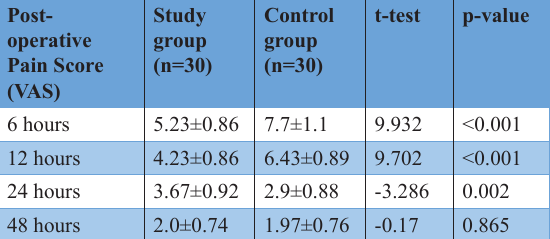
Table2. Comparisons of postoperative pain score (VAS)